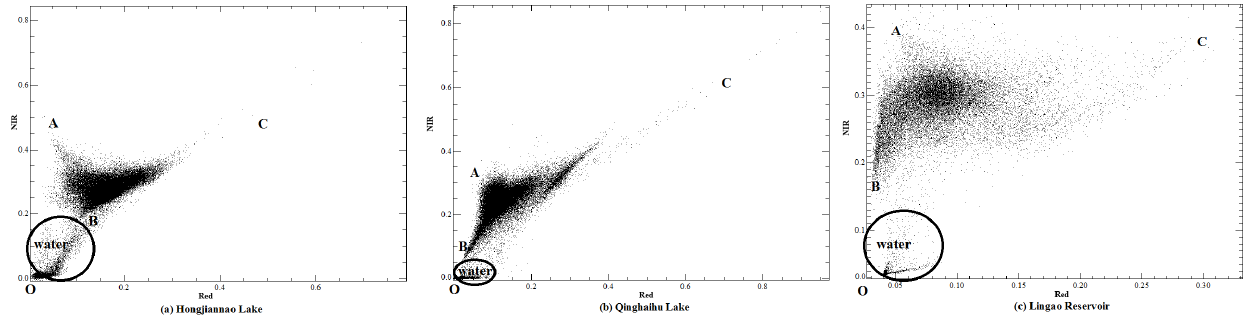
Figure 1. Spectral space using reflectance data of red and NIR bands